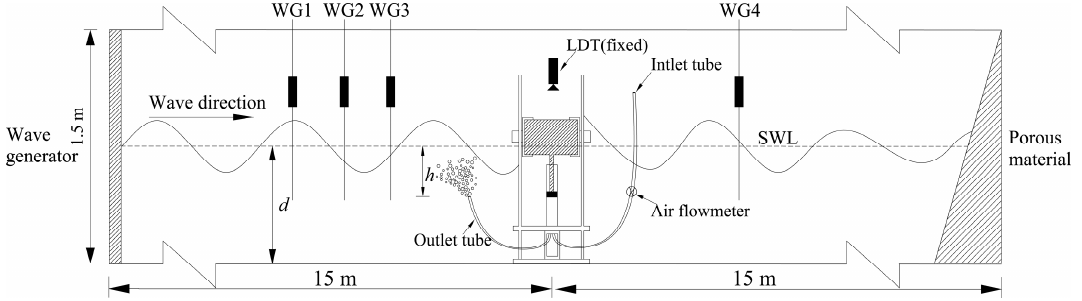
Figure 2. Experimental sketch.